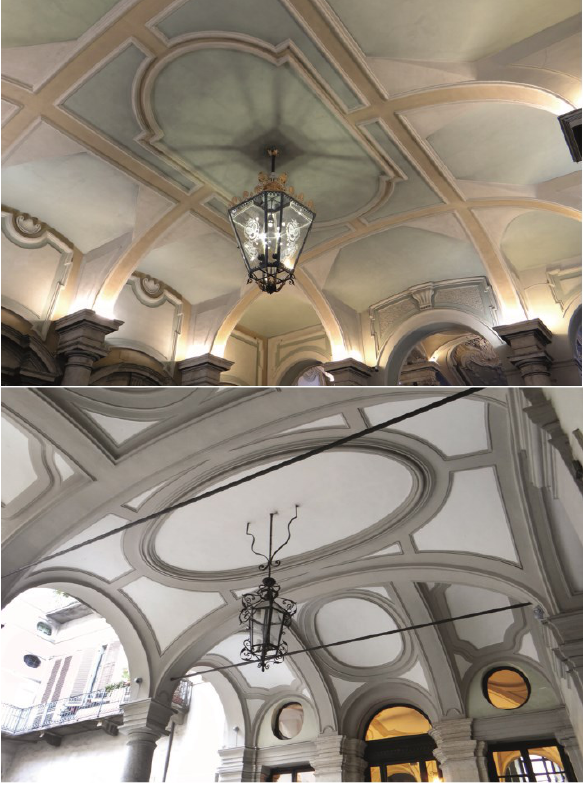
Figure 4. Banded vault with independent arches in Palazzo Barolo (top) and with arches belonging to the main surface in the palace in via Garibaldi 53 (bottom). Photos: M.